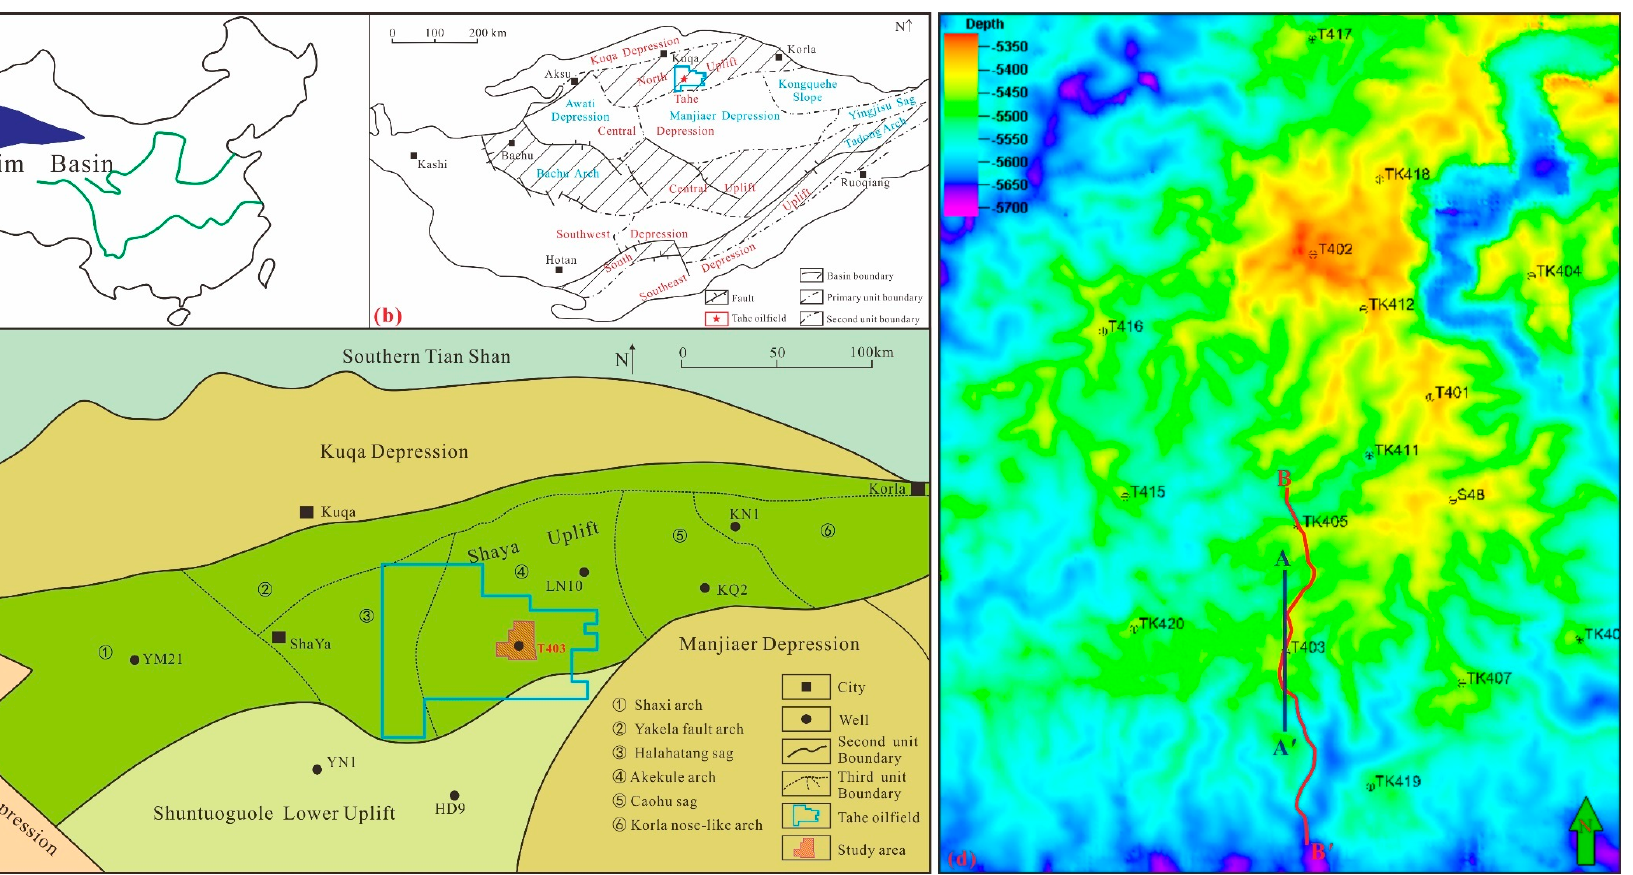
Figure 1. The structural maps of Tarim Basin and the study area, modified from Tian et al. [10,26] and Lu et al. [41]. ( a ) Tarim Basin located in western China; ( b ) The tectonic units in the Tarim Basin, mainly including four uplifts and three depressions; ( c ) The Tahe Oilfield is located in the Akekule Arch, the North Uplift of Tarim Basin; ( d ) Time domain map of Yingshan Formation buried depth.